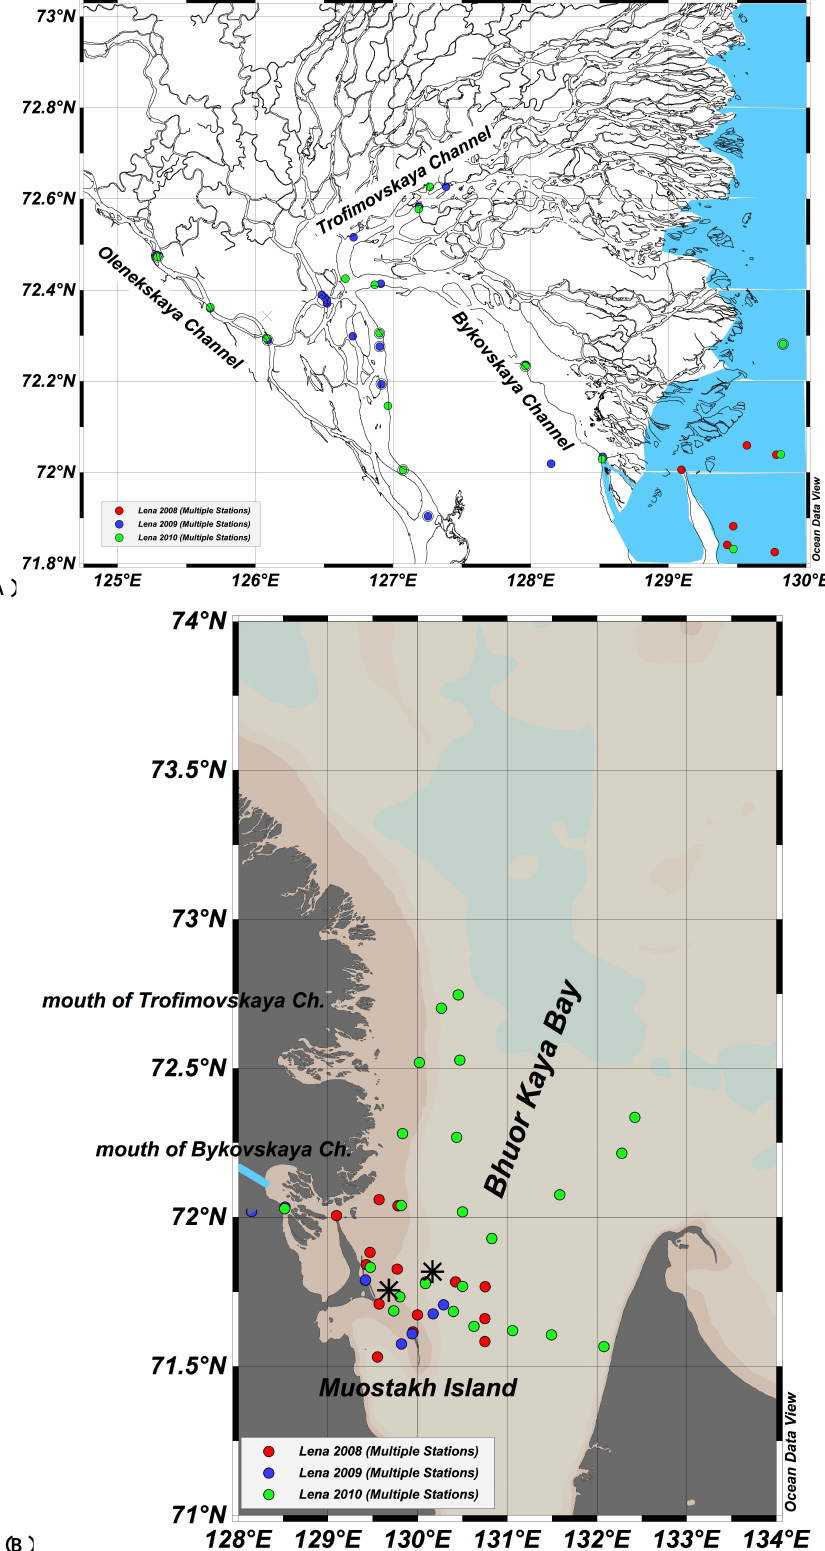
Fig. 1. Sampling stations in the years 2008 (red), 2009 (blue) and 2010 (green) within the Lena Delta and Buor-Khaya Bay. (A) shows the river stations, (B) the estuarine stations. Asterisks indicate stations with special isotopic